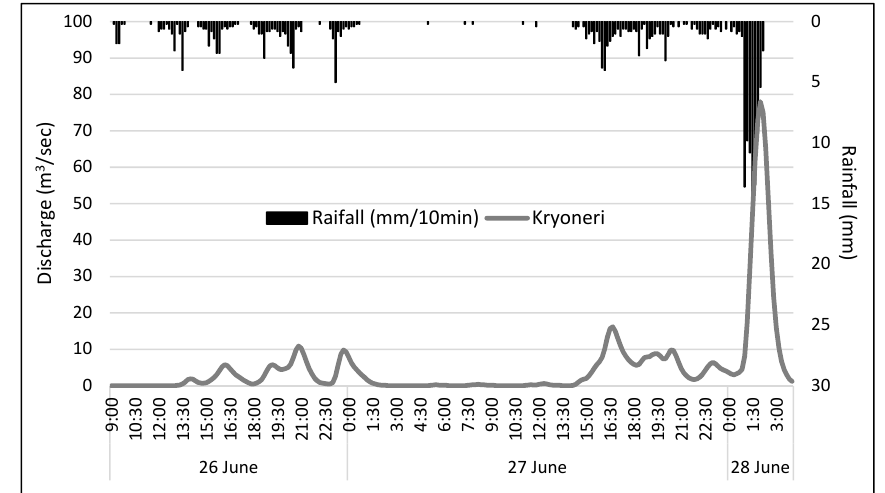
Figure 13. Observed and simulated (after the model calibration) hydrographs of the October 2010 flood event at Vatonias stream.